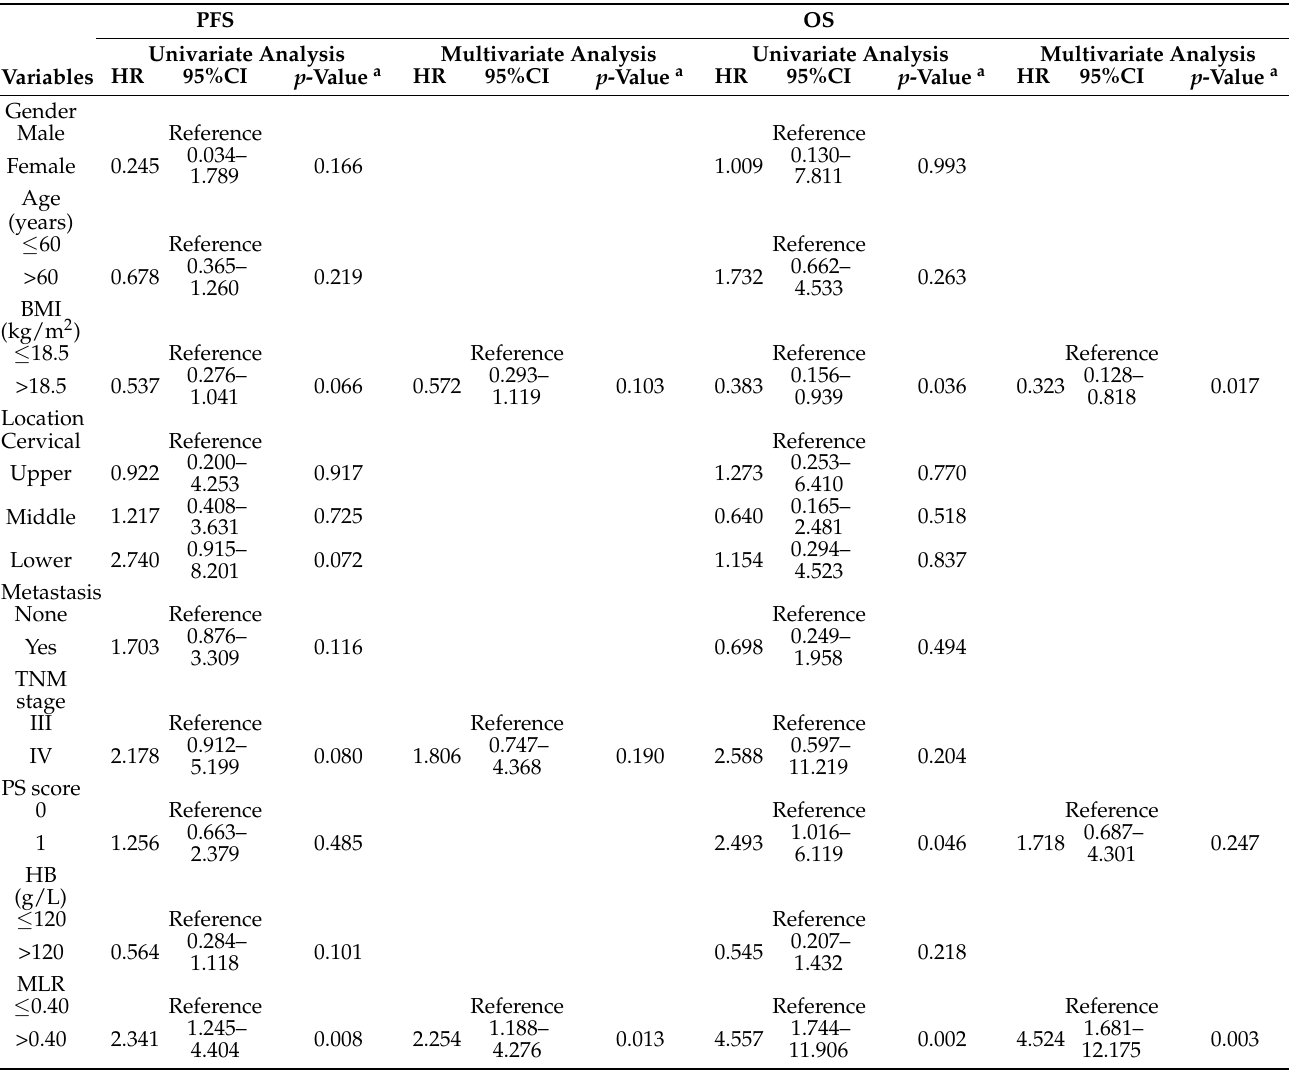
Table 3. Univariate and multivariate Cox regression analyses for PFS and